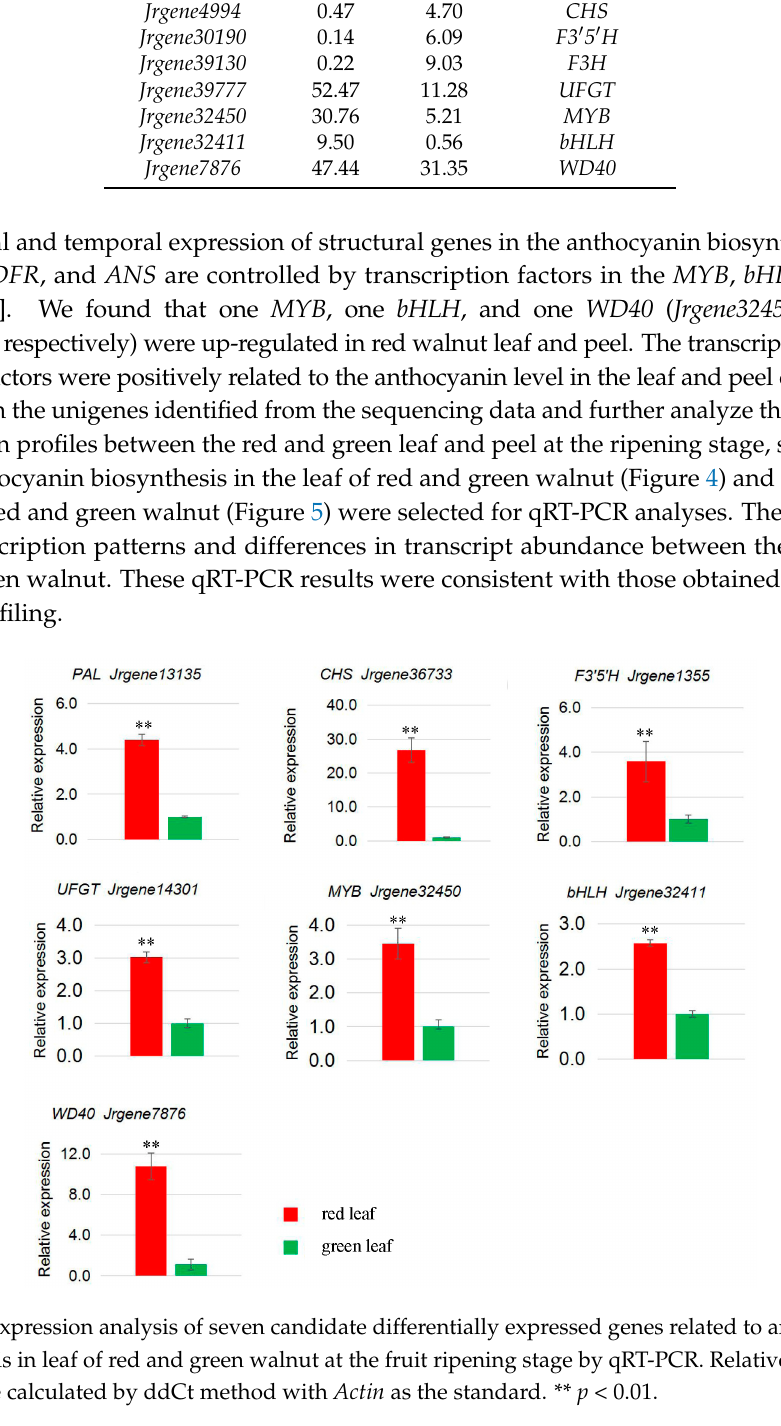
Figure 5. Expression analysis of eight candidate differentially expressed genes related to anthocyanin biosynthesis in the peel of red and green walnut at the fruit ripening stage by qRT-PCR. Relative transcript levels were calculated by the ddCt method with Actin as the standard. * p < 0.05, ** p < 0.01.